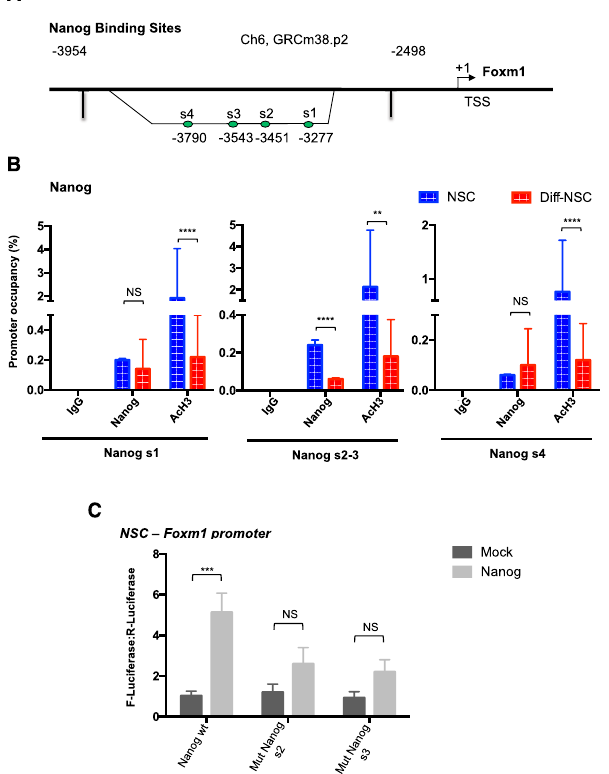
Foxm1 promoter region in NSCs and Diff-NSCs. Immunoprecipitation with IgG was performed as control. Anti-acetyl-H3 antibodies was used to identify Foxm1 transcriptional activation. Eluted DNA was PCR- amplified with primers for Nanog binding sites s1, s2-s3, s4. Results are expressed as fold induction values relative to input controls. B-actin was utilized as unrelated chromatin control and is presented in Supplementary Figure 7A. Bars represent means (SD) of three independent experiments. P values vs. Diff-NSCs (Mann- Whitney U test): ** P < 0.01: 0.002572 (s2-3, AcH3); **** P < 0.0001: 0.00000718 (s2-3, Nanog), 0.0001051 (s1, AcH3), 0.00004356 (s4, AcH3); NS: 0.4531 (s1, Nanog), 0.7118 (s4, Nanog). ( C ) Luciferase activity induced by ectopic expression of Nanog and Mock (negative control, PCDNA) in NSCs transfected with luciferase vector carrying the wild-type Foxm1 promoter (wt) and its mutant lacking the Nanog binding sites s2 and s3 (mutants s2, s3). Bars represent means (SD) of at least three independent experiments, each performed in triplicate. P values vs. indicated controls (Mann–Whitney U test). *** P < 0.001: 0. 000937 (Nanog wt); NS: 0.097 (Mut Nanog s2), 0.18 (Mut Nanog